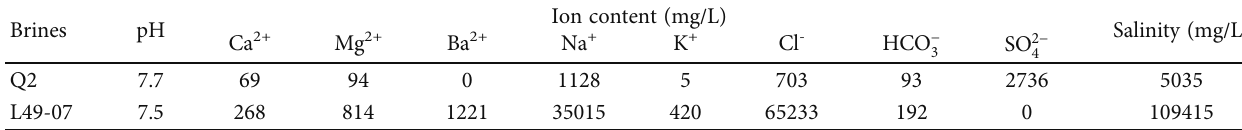
Table 1: Ionic composition of formation water and injection water.